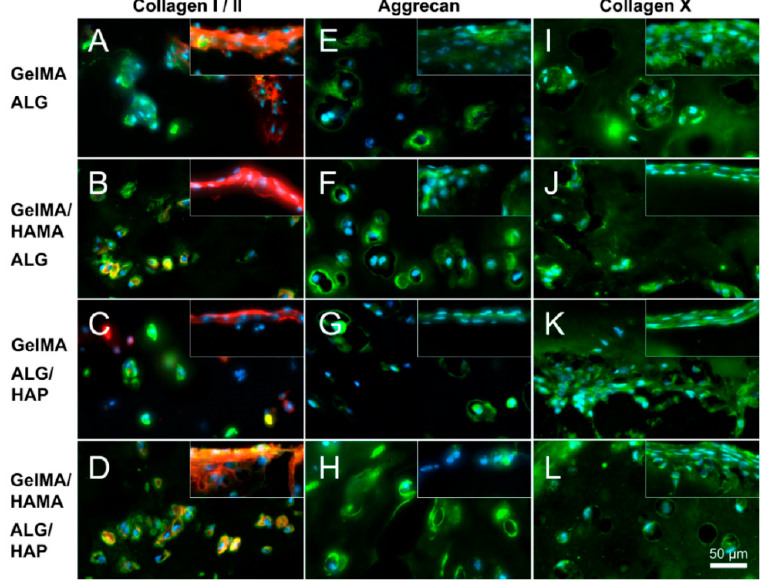
Figure 8. Immunofluorescence images illustrating deep and surface sections. Staining of collagen I (red), collagen II (green), aggrecan (green) and collagen X (green) was performed on constructs from all groups on day 28 (as indicated; DAPI nuclei staining in light blue); ( A , E , I ): GelMA-ALG; ( B , F , J ): GelMA/HAMA-ALG; ( C , G , K ): GelMA-ALG/HAP and ( D , H , L ): GelMA/HAMA-ALG/HAP. Images were taken from the deep hydrogel zone near to the ALG or ALG/HAP scaffold, with surface images inset; scale bar 50 µm.